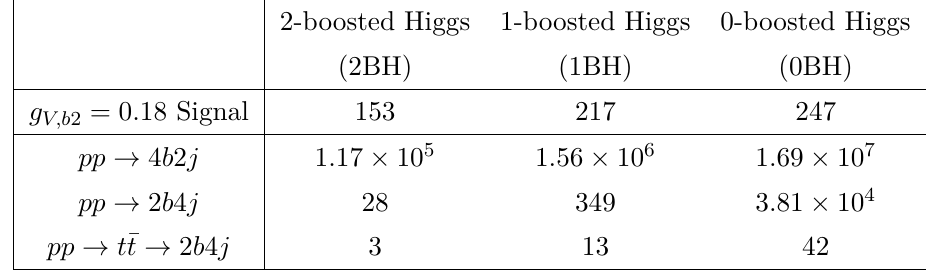
Table 10 . The numbers of 2BH, 1BH and 0BH cases at 14 TeV LHC are tabulated.